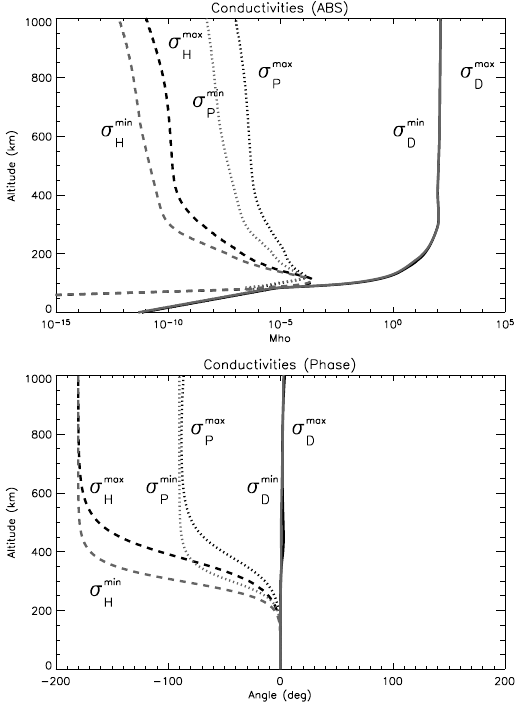
Fig. 1. The direct (solid), Pedersen (dotted)) and Hall (dashed) conductivities for solar minimum and maximum following Hughes (1974). An incident 16mHz ( ω =0.1) ULF wave was used.